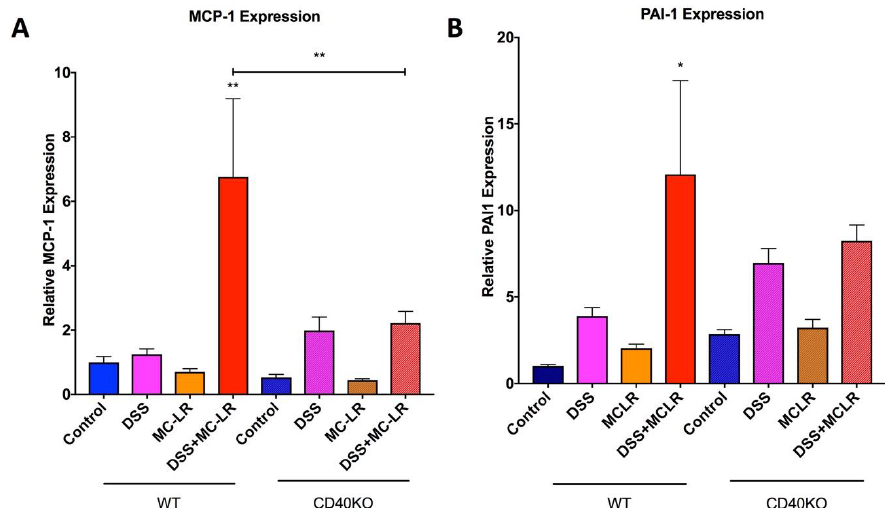
Figure 7. RT-qPCR analysis of pro-inflammatory and pro-fibrotic cytokines and